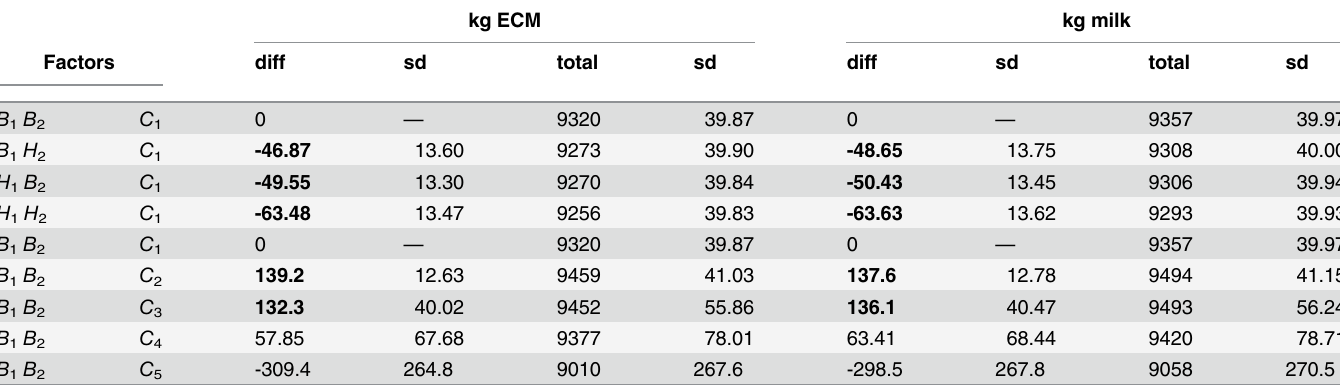
Table 5. Milk production in parity two, all offspring